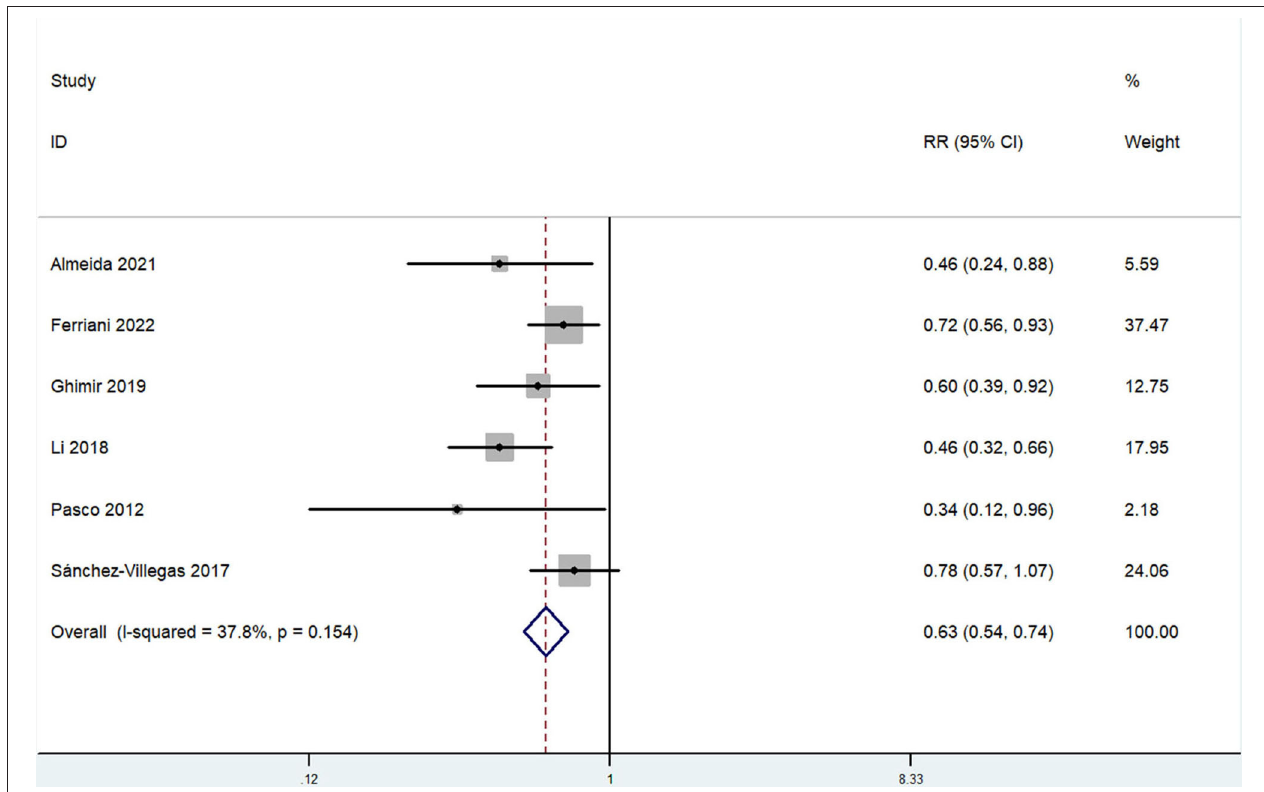
FIGURE 3 | Forest plot of meta-analysis: overall multi-variable adjusted RR of depression for the highest vs. lowest category of dietary selenium intake.